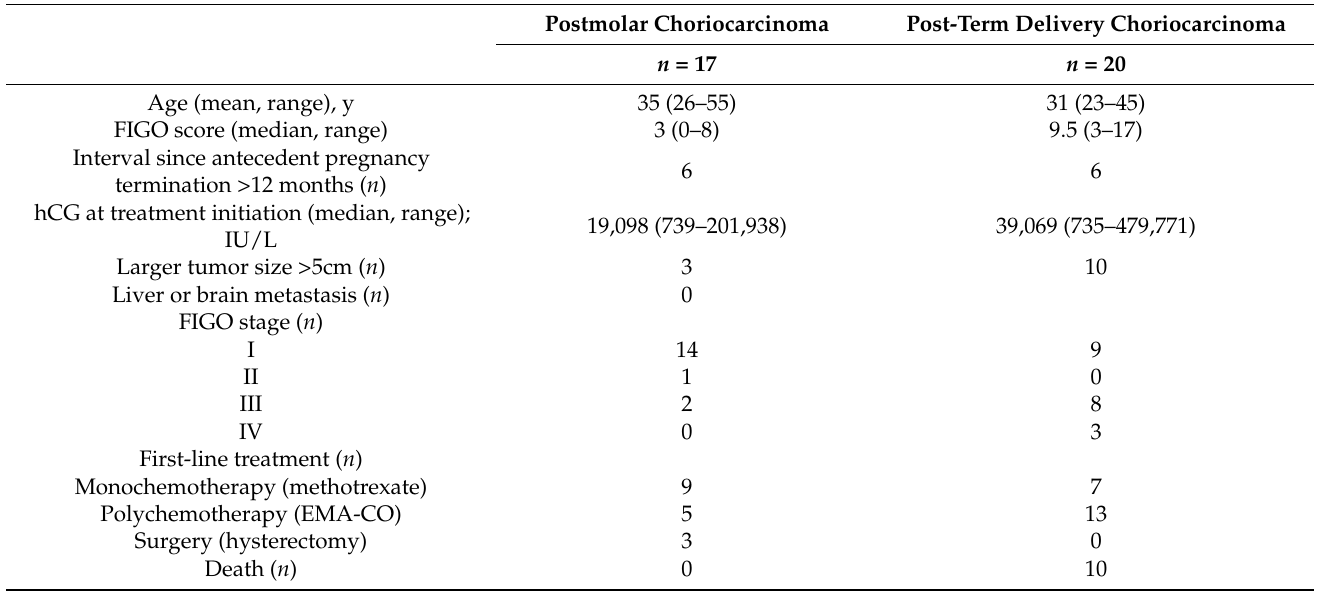
FIGO, F é d é ration Internationale des Gyn é cologues et Obst é triciens; hCG, human chorionic gonadotropin; IU/L, international units/liter; D&C, dilatation and curettage; EMA-CO, etoposide, methotrexate and actinomycin-D alternated weekly with cyclophosphamide and vin-